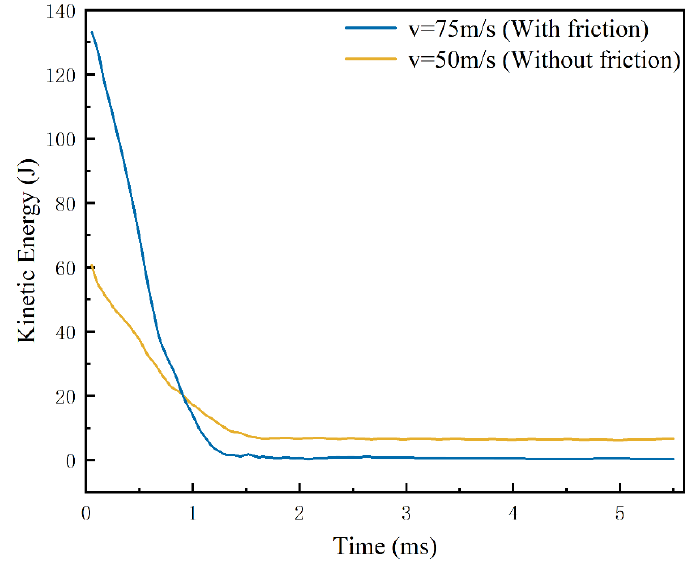
Figure 12. Kinetic energy curve.